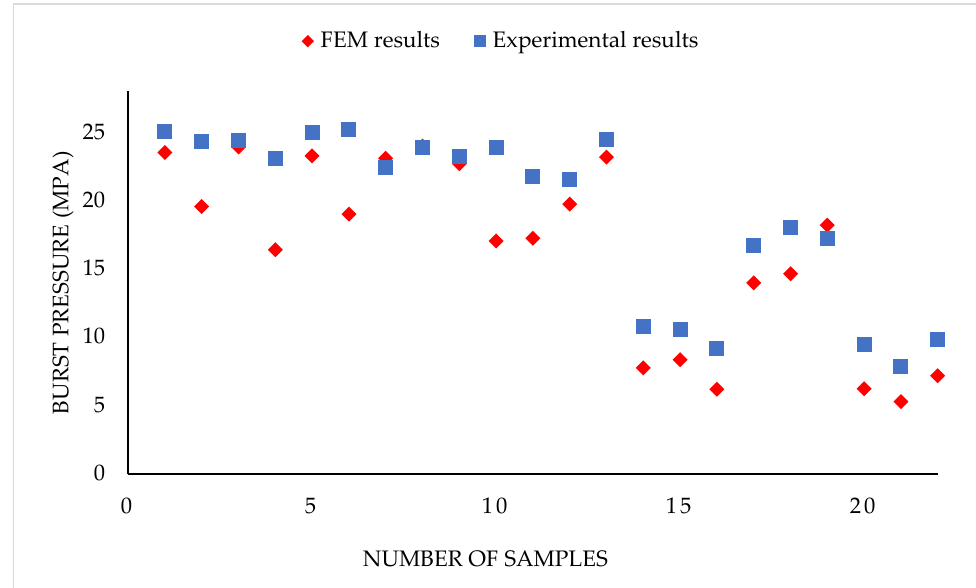
Figure 5. Comparison of FEM analysis with experimental results for the 22 samples of X46 and X52 grade pipes.